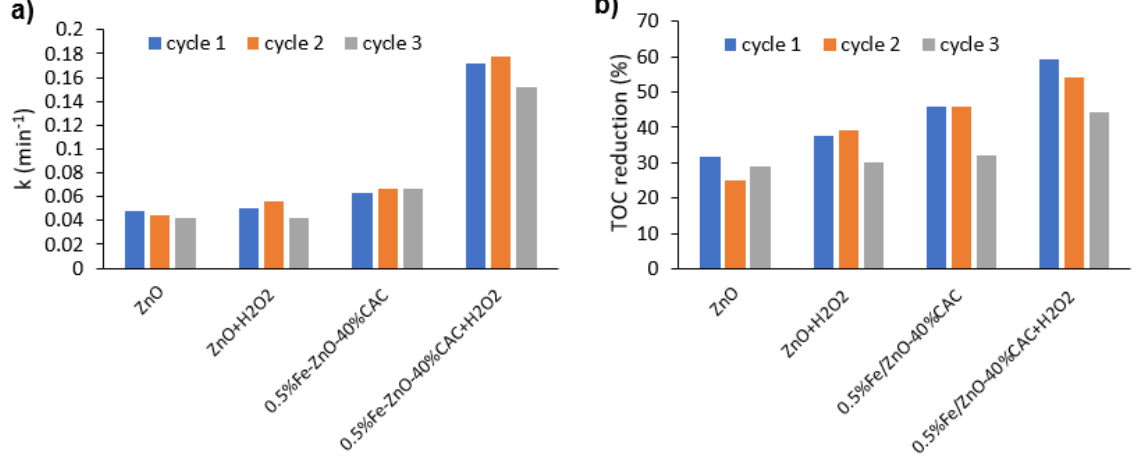
Figure 11. Ibuprofen photocatalytic decomposition ( a ) and mineralization measured as TOC reduc- tion ( b ) over ZnO, 0.5%Fe-ZnO-40%CAC and H 2 O 2 during subsequent photodegradation cycles.